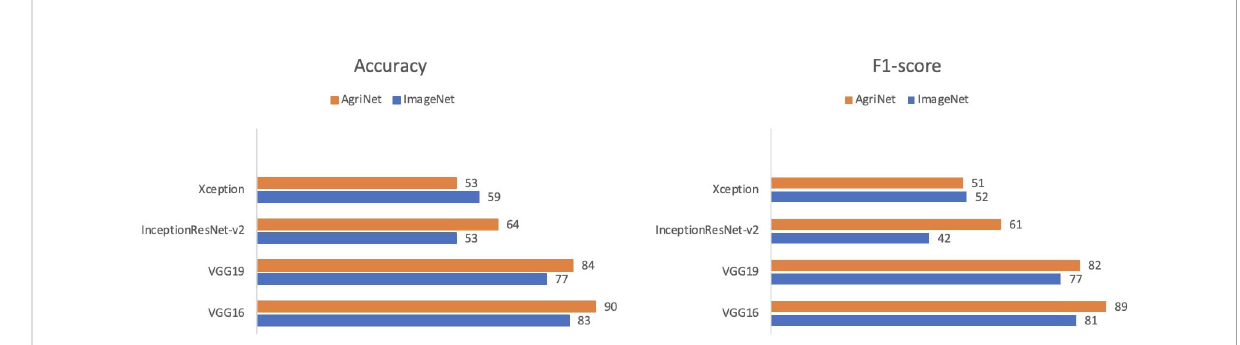
FIGURE 4 Models comparison on plant diseases of kashmir